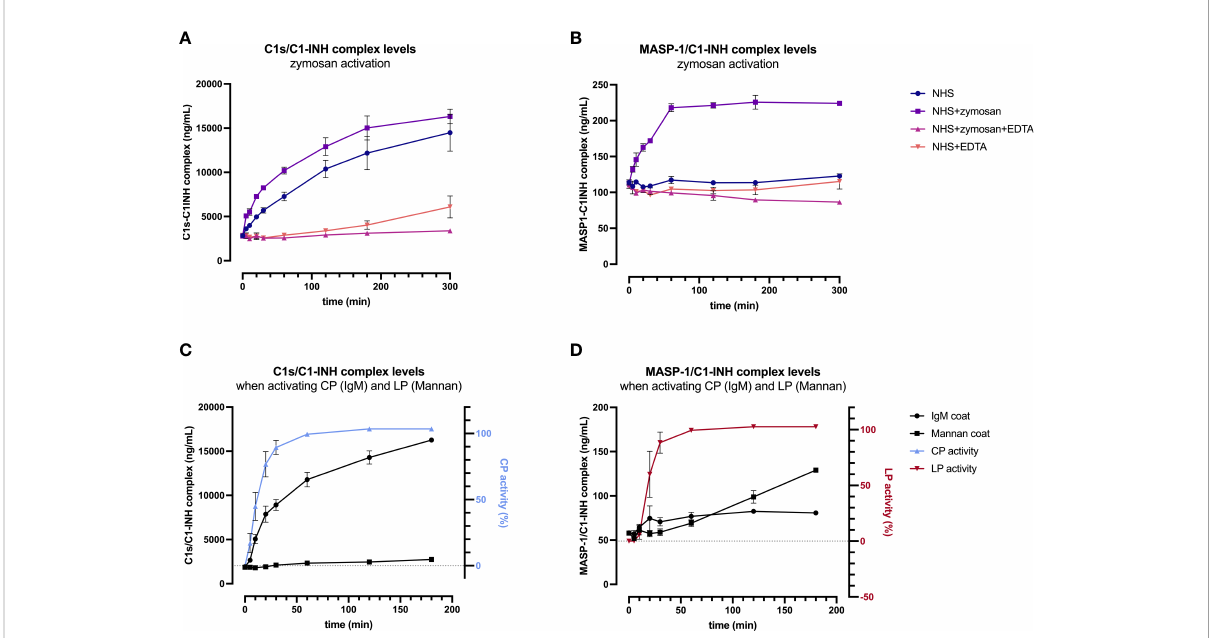
FIGURE 6 Validation of C1-INH complexes as activation markers: zymosan-initiated (A, B) and pathway-speci fi c (C, D) complex formation over time. For zymosan- activation (A, B) , normal human serum was incubated either alone or with zymosan, EDTA, or a mix thereof, for up to 5 hours at 37 °C. Samples were taken at several time points and concentrations of C1s/C1-INH complex (A) and MASP-1/C1-INH complex (B) were determined using the new immunoassays. Plotted values show C1-INH complex concentrations (mean ± SD) of two independent activation experiments performed in duplicates each, while effects of added compounds (zymosan, EDTA) and incubation time on C1-INH complex levels were analyzed with a two-way ANOVA with Tukey ’ s multiple comparisons test. For the C1s/C1-INH complex, a statistically signi fi cant effect was seen for the zymosan-treated sample for both, the incubation time (p<0.0001) as well as the treatment (NHS+zymosan vs. NHS: p=0.0399, NHS+zymosan vs. NHS+zymosan+EDTA: p<0.0001, NHS +zymosan vs. NHS+EDTA: p<0.0001). For the MASP-1/C1-INH complex, the zymosan-treated sample did also show statistically signi fi cant effects for the incubation time (p<0.0001) as well as the treatment (NHS+zymosan vs. all other treatments tested: p<0.0001). For pathway-speci fi c activation (C, D) , normal human serum was incubated on wells coated with either IgM (CP) or mannan (LP), for up to 3 hours at 37 °C. After incubation, C1-INH complex levels were determined in the supernatant ( C : C1s/C1-INH complex; D : MASP-1/C1-INH complex), while C9 neoepitope formation was measured on the respective wells (WIESLAB ® Complement System kits). Plotted values show mean concentrations of C1-INH complexes (mean ± SD) and normalized CP and LP activity (as measured by C9 neoepitope formation using positive and negative controls provided in the kits) of three independent experiments. NHS, normal human serum; EDTA, ethylenediaminetetraaceticacid; SD, standard deviation; min, minutes; IgM, immunoglobulin M; TCC, terminal complement